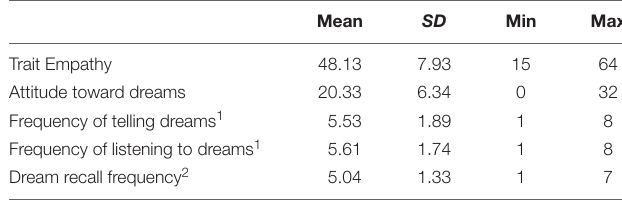
TABLE 1 | Descriptive statistics of trait empathy and dream variables.